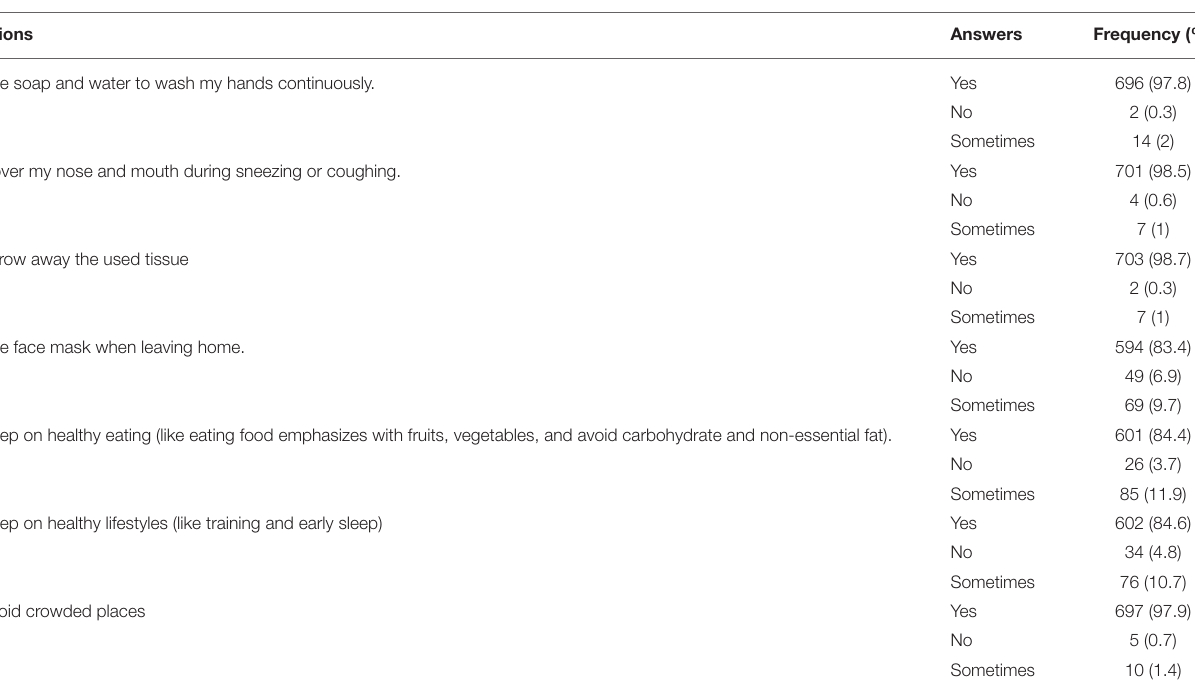
Table 6 | Frequency distribution of participant’s response on practice related questions on COVID-19 ( N = 712).